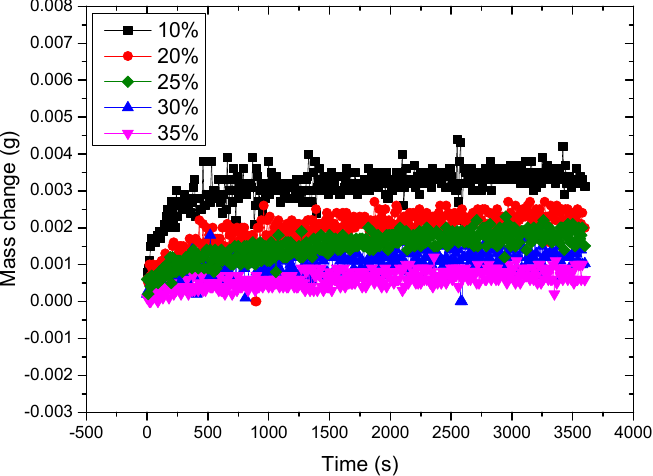
Figure 11. Evaporation rates of LiCl solution with the solar steam structure material (20 mL).